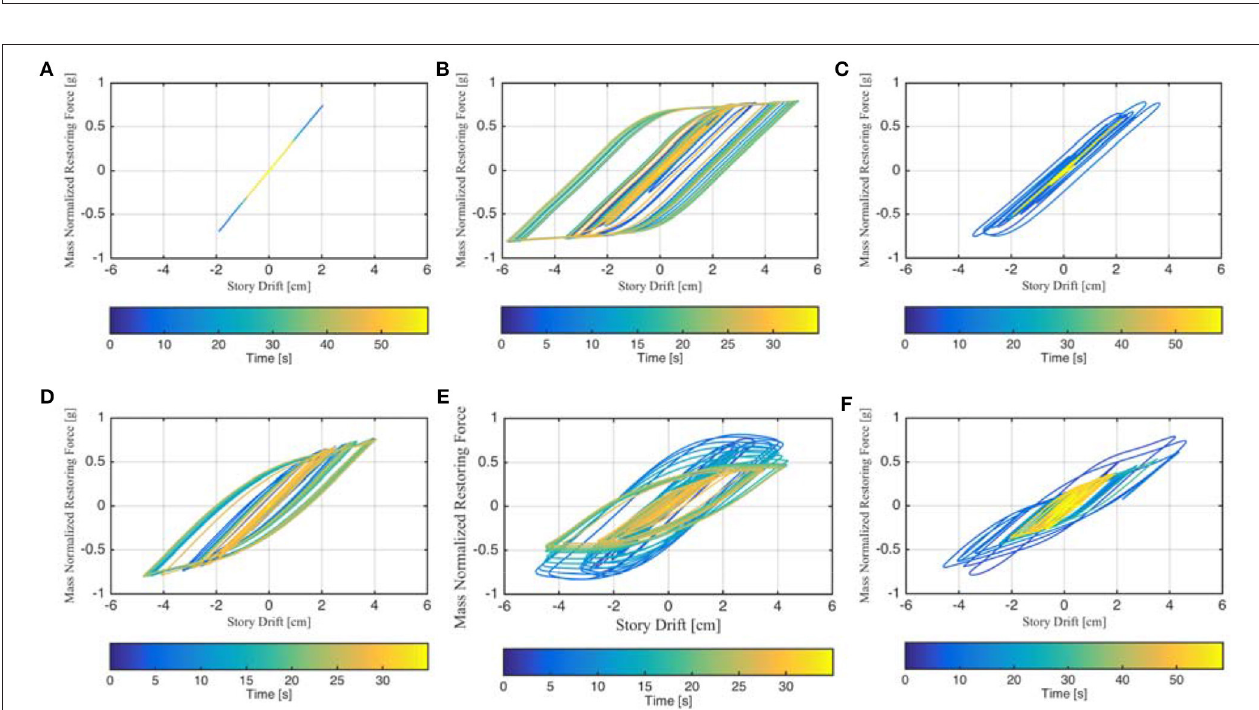
FIGURE 8 | Mass-normalized damping coefficients—inelastic with degradation in stiffness and in strength.